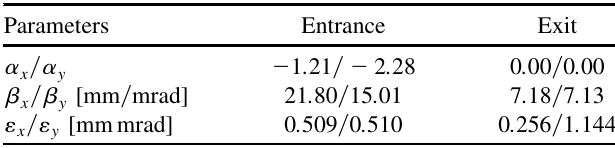
45 (cid:6) around the beam direction. The decoupling section starts at the exit of the solenoid and ends behind the last skew quadrupole. The beam parameters at the entrance and exit of the beam line are listed in Table II.